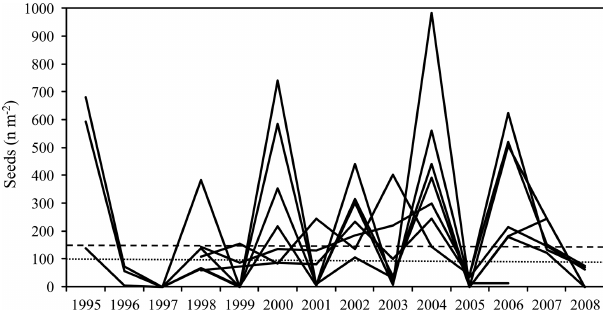
Figure 1. Production of seeds (seeds per square meter) at the study sites. Horizontal lines indicate years with half-mast (100–149 seeds per square meter – dotted line) and full-mast ( ≥ 150 seeds per square meter – dashed